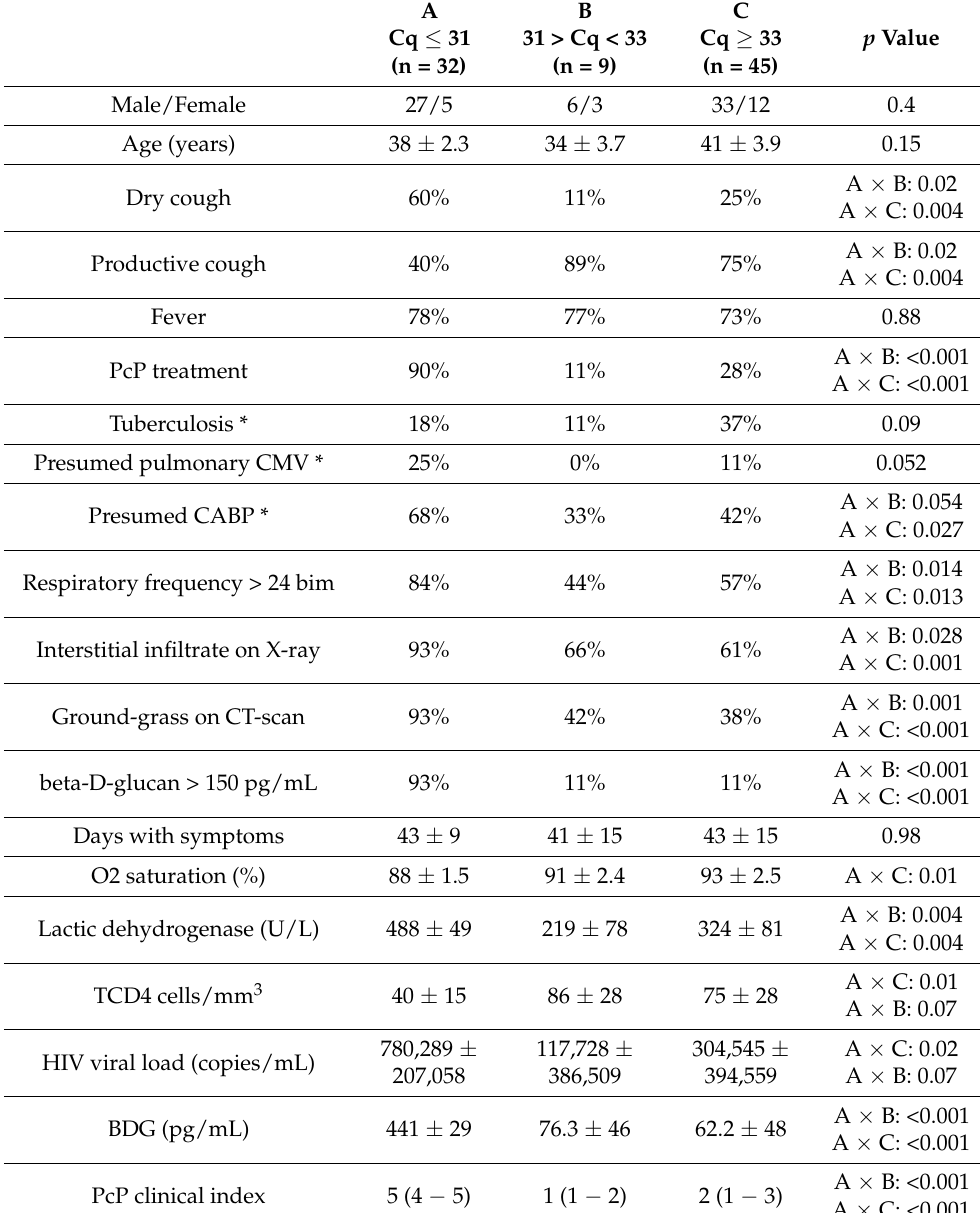
Table 1. Clinical, radiological and laboratorial data from the three groups of patients according to their Cq